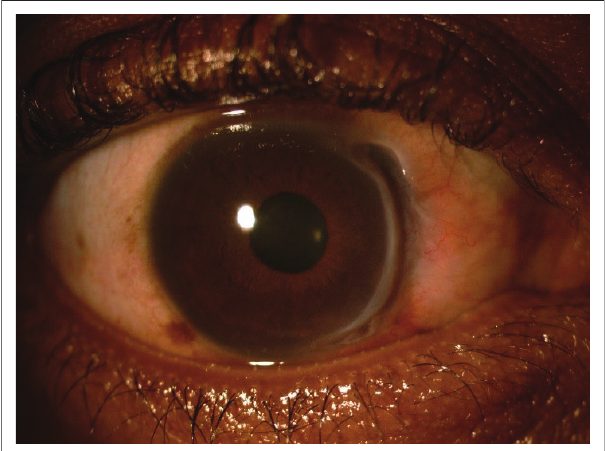
FIGURE 2: Anterior segment photograph of a right eye with peripheral ulcerative keratitis.